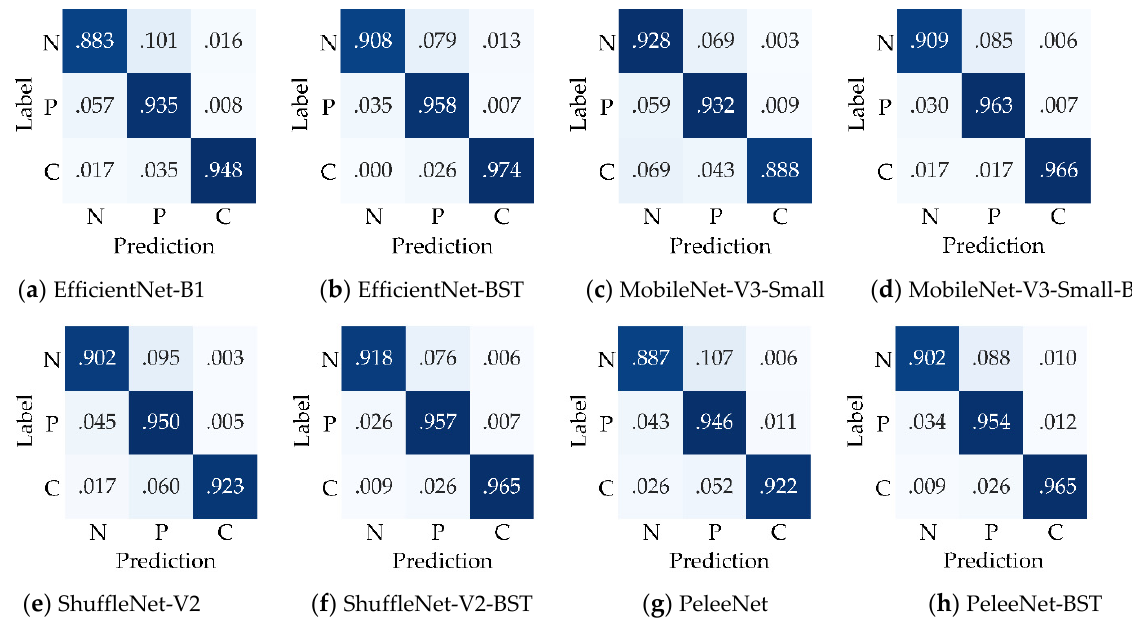
Figure 9. Confusion matrixes of the compared networks trained with CE loss or CE+BST loss on the Chest-1 dataset. “N”, “P” and “C” denote normal images, pneumonia images and COVID-19 images, respectively.